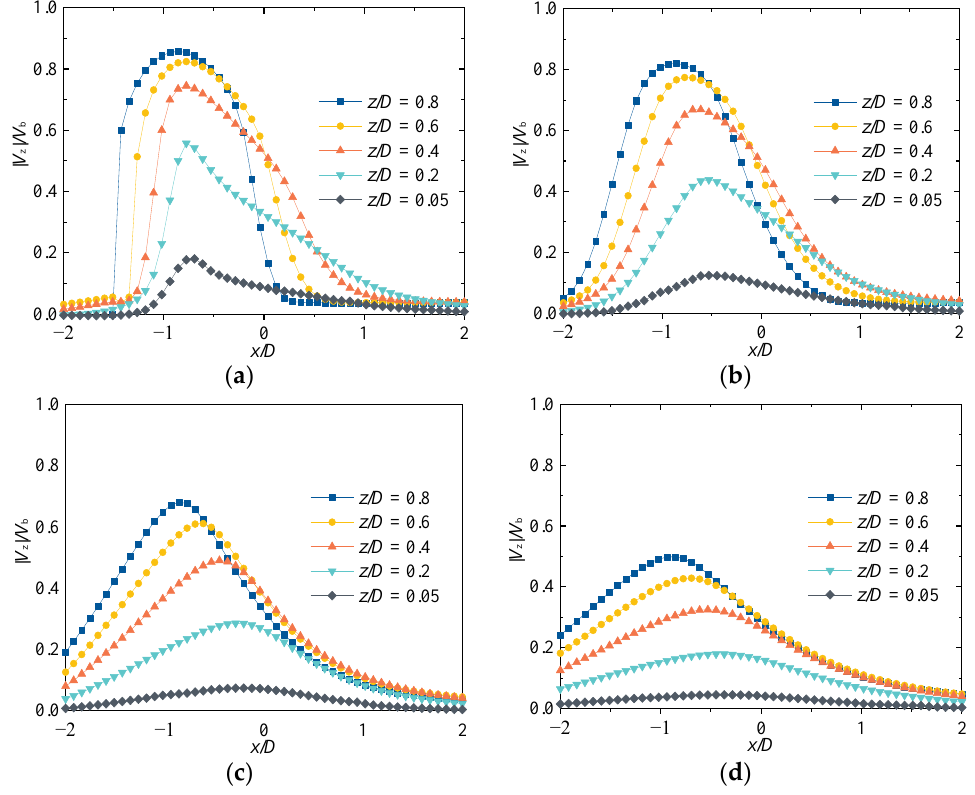
Figure 13. Development of mean vertical velocity ( |V z |/V b ) along the horizontal direction at different vertical locations on the near-well region: ( a ) H/D = 1; ( b ) H/D = 3; ( c ) H/D = 6; ( d ) H/D = 8. The distribution law of the maximum velocity V m /V b of the wall jet along the forward flow direction is shown in Figure 15 ( Re = 35,100). As shown in the figure, when H/D ≤ 6, there is a large difference in velocity V m /V b at various impinging heights in the range of 1 ≤ x/D ≤ 4, and the difference is small in the range of x/D > 4, which is in good agreement with the fitting formula V m /V b = 2.3( x/D ) − 1 ; when H/D = 8, the calculated results in the range of x/D > 8 are in good agreement with the